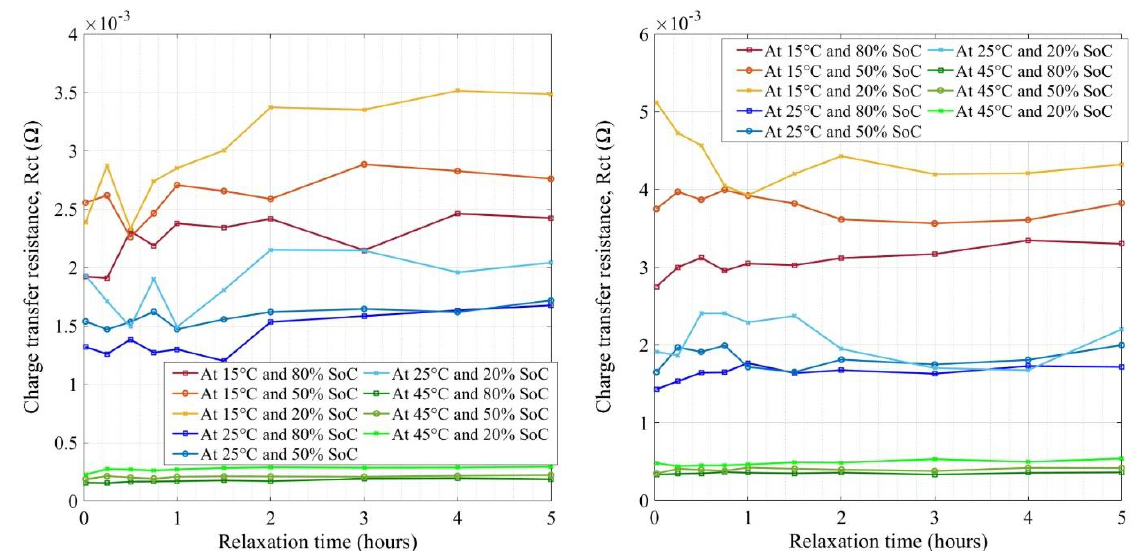
Figure 14. Charge transfer resistance for new ( left ) and aged ( right ) LFP cells.